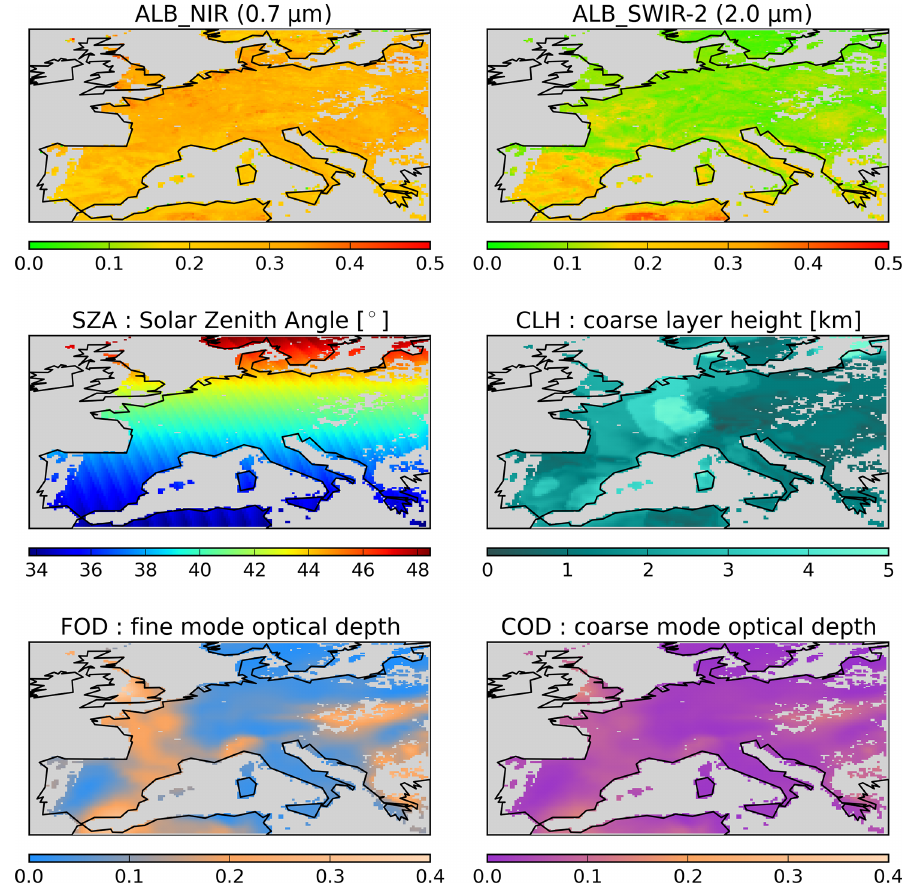
Figure 12. ALB_NIR, ALB_SWIR-2, SZA, CLH, FOD and COD cloud-free parameter maps of 1 July 2015, averaged on a 0 . 2 ◦ × 0 . 2 ◦ grid.